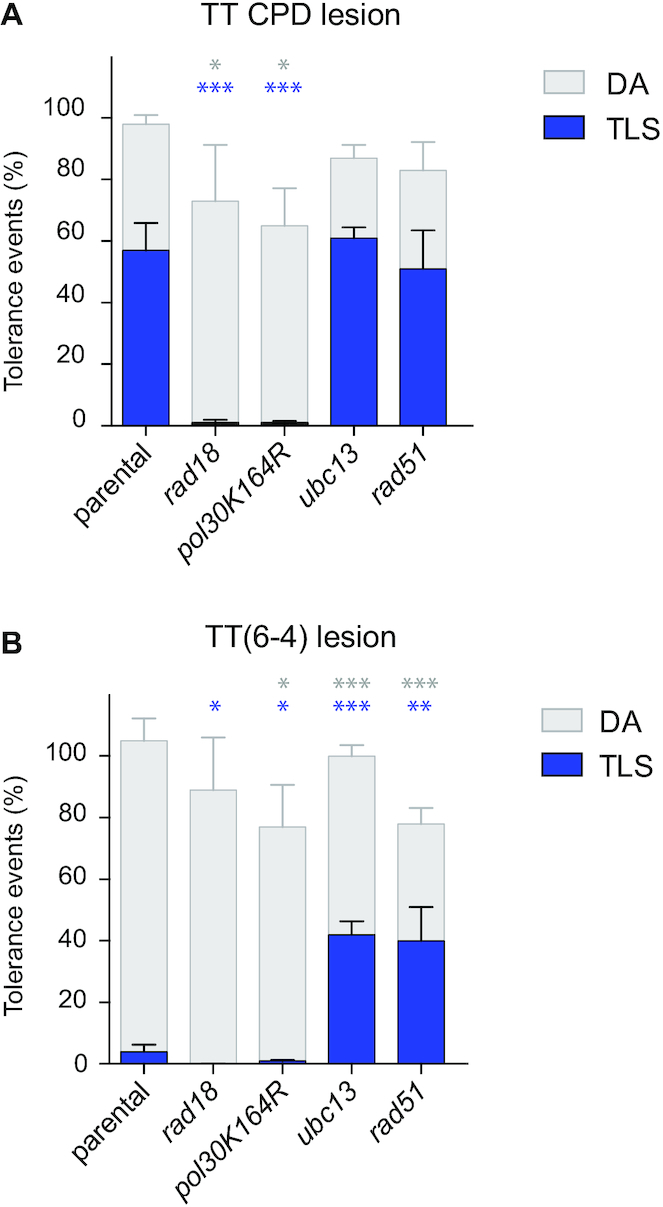
Partitioning of DDT pathways in the absence of PCNA ubiquitination and in rad51 mutant. Bypass of TT-CPD (A) and TT(6-4) (B) lesion in strains deficient in PCNA ubiquitination (rad18 or pol30-K164R) or polyubiquitination (ubc13). Tolerance events represent the percentage of cells able to survive in presence of the integrated lesion compared to the lesion-free control. The data represent the average and standard deviation of at least three independent experiments in which the lesion has been inserted either in the leading or the lagging strand. Unpaired t-test was performed to compare TLS and DA values from the different mutants to the parental strain. *P < 0.05; **P < 0.005; ***P < 0.0005. All strains are phr1Δ rad14Δ msh2Δ::hisG. In the absence of PCNA ubiquitination (rad18, pol30 K164R) we observed a decrease in TLS. The remaining low level of TLS is probably due to polymerase interactions with PCNA ring not involving ubiquitin moiety. In the absence of PCNA polyubiquitination (ubc13), a small increase of the TLS bypass of the CPD lesion is observed, while Pol ζ-mediated bypass of the TT(6-4) lesion increased more than 10 fold. The absence of recombinase Rad51 results in a similar increase in TLS.